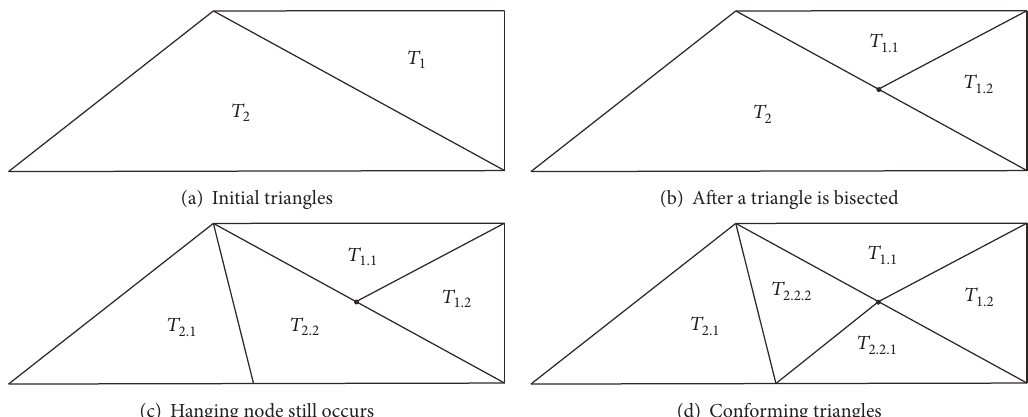
Figure 1: Illustration of the refinement